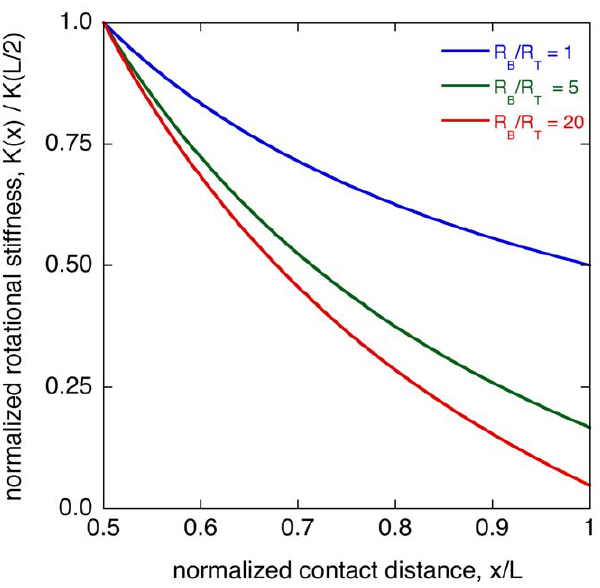
Figure 4. Rotational stiffness. Normalized rotational stiffness, K(x)/ K(L/2), calculated for various truncated conical elastic beams. Top to bottom, the three curves correspond to tapers ( R B / R T ) of 1 (the untapered case), 5, and 20. We only show the distal half of the whisker, since whisker contacts are distal during natural behaviors [5].